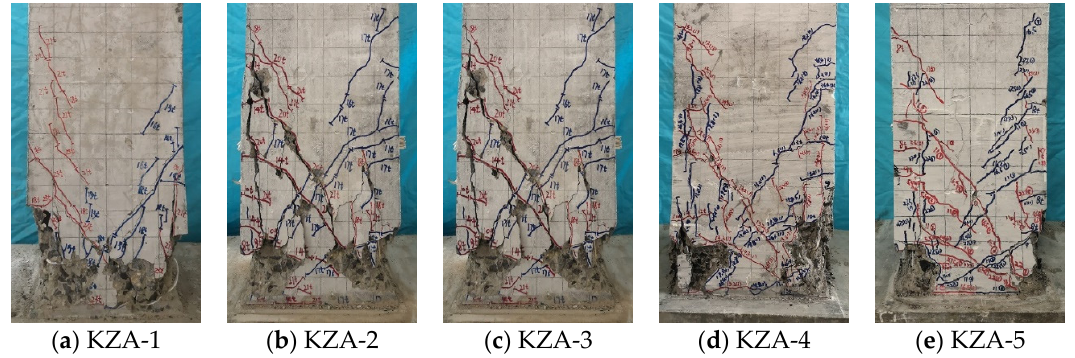
Figure 6. Failure modes of specimens.